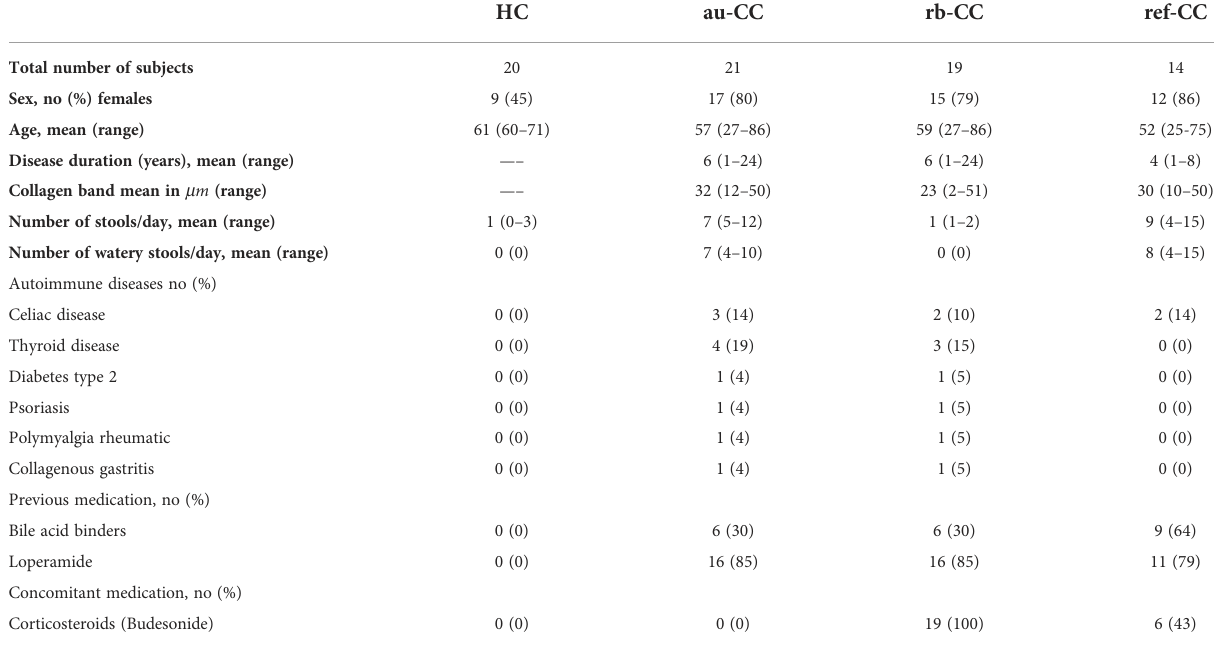
TABLE 1 Demographics and clinical characteristics of patients and